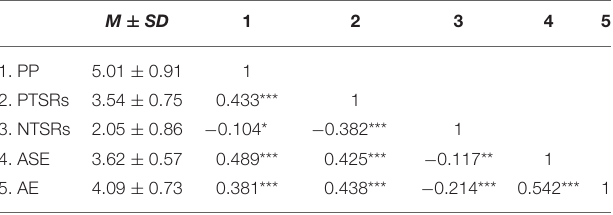
TABLE 1 | Descriptive statistics and correlations among